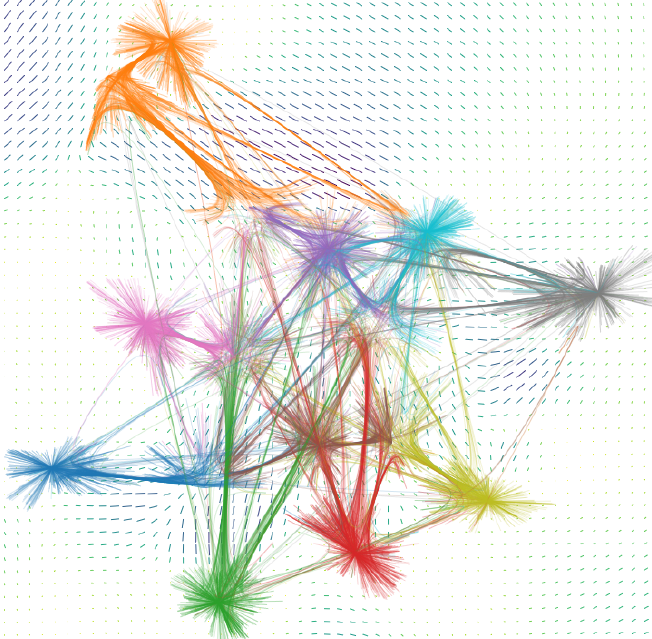
Figure 5. Trajectory data from the same outputs as the Figure 4 (last hidden layer of MLP after 20 epochs using MNIST test data as input). Lines start from instance positions at epoch 0 and end in instance positions at epoch 20. Control points were set along the streamlines defined previously, attracting lines near them into